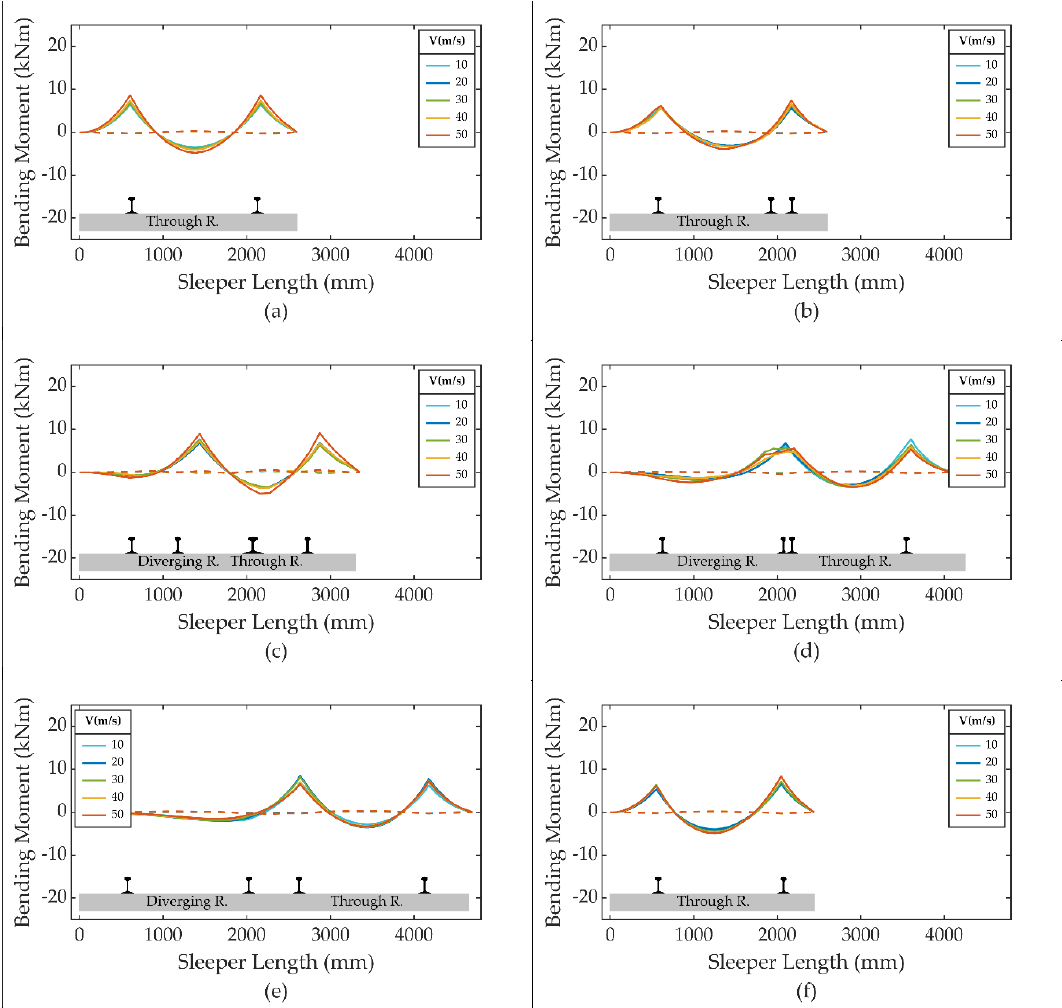
Figure 29. The flexural responses of adjacent bearers when the selected point have maximum and minimum bending moments: ( a ) Bearer at normal track section; ( b ) Bearer under switch blades; ( c ) Bearer at closure panel; ( d ) Bearer under crossing nose; ( e ) The longest bearer; ( f ) The shortest bearer.